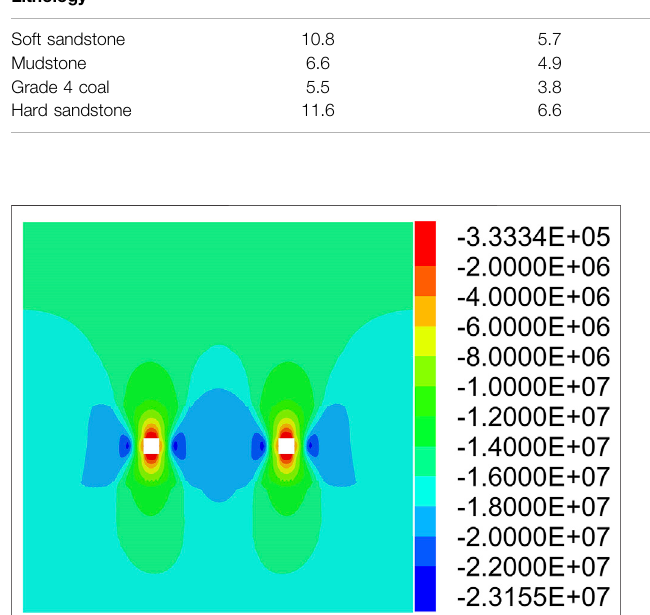
FIGURE 15 | Cloud diagram of the plastic